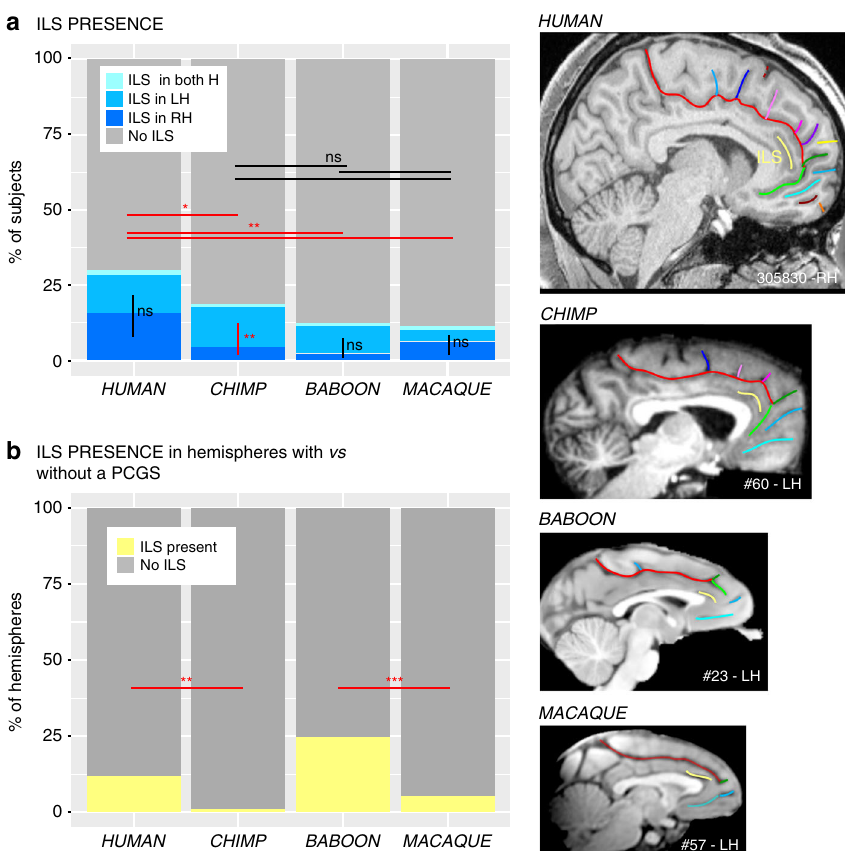
Fig. 2 Presence of the ILS across primates. The location of the ILS is shown in yellow in typical hemispheres of the human, chimpanzee, baboon, and macaque monkey brains (right panels). a The probability of occurrence of an ILS is higher in human compared with non-human primate brains. A post-hoc Tukey test indicated no signi fi cant difference in the presence of the ILS in the three non-human primate species. Only in chimpanzee brains, the probability of observing an ILS is higher in the left than in the right hemisphere. No difference between the probability of occurrence of ILS in the left versus right hemisphere was found in human, baboon, and macaque brains. b In Hominoidea, when a PCGS is present, the ILS is almost always absent. Statistics: * p < 0.05, ** p < 0.01, *** p < 0.001, ns non-signi fi cant. Source data are provided as a Source Data fi